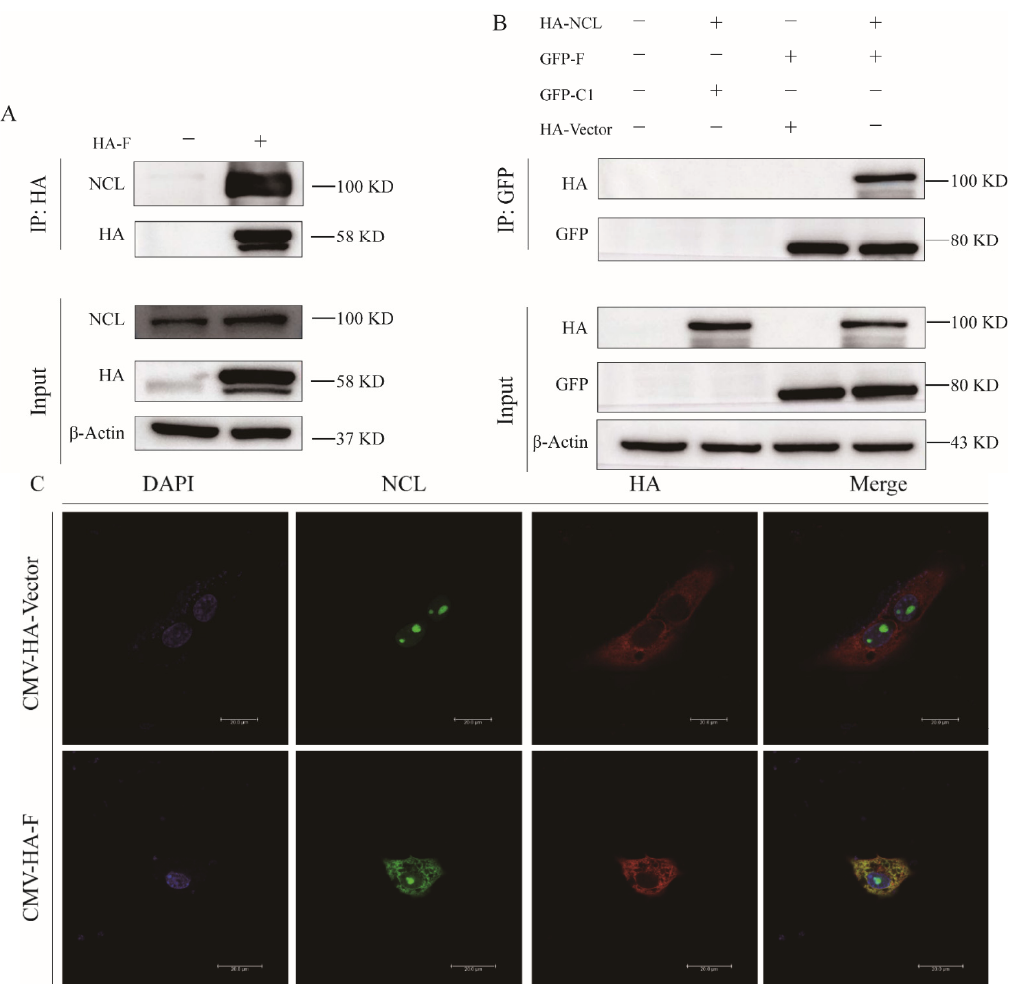
Figure 4. aMPV/C F protein interacts with NCL. ( A ) Vero cells were transfected or not transfected with the pCMV − HA − F plasmids for 36 h and an IP assay on cell lysates was performed using HA mAb, followed by immunoblotting with mAbs against HA and NCL. ( B ) The plasmids of pCMV − HA − NCL and pEGFP − C1 − F were co − transfected into HEK293 cells for 36 h, a Co − IP assay was subsequently performed using GFP mAb, followed by immunoblotting with mAbs against HA and GFP. ( C ) Vero cells transfected or not transfected with pCMV − HA − F were incubated with NCL antibody (green), HA antibody (red), and DAPI (blue), and then observed by confocal microscopy. Scale bar, 200 µ